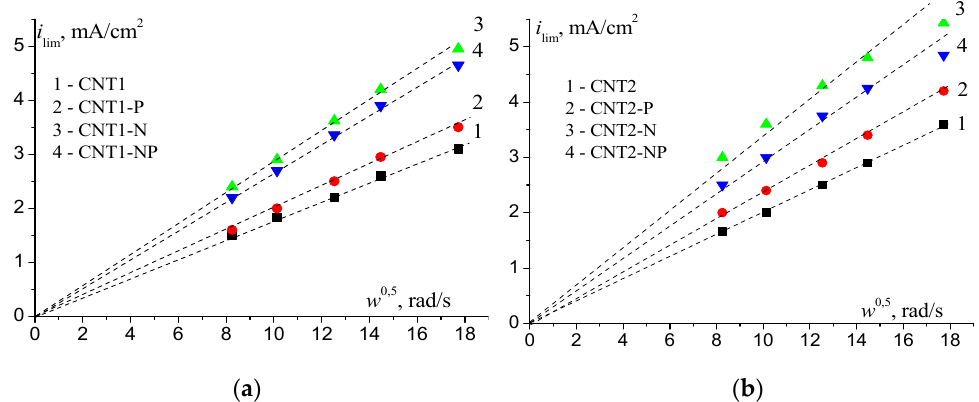
Figure 4. Dependence of i lim on w 0.5 for modified CNTs functionalized: ( a ) in NaOH and ( b ) in HNO 3 , O 2 -saturated 0.1 M KOH, the potential scan rate is 5 mV / s; m cnt = 0.15 mg / cm 2 . Each dependence is built on the basis of polarization curves at five electrode rotation speeds (w, (rad / s) = 68, 103, 157, 209, 314).